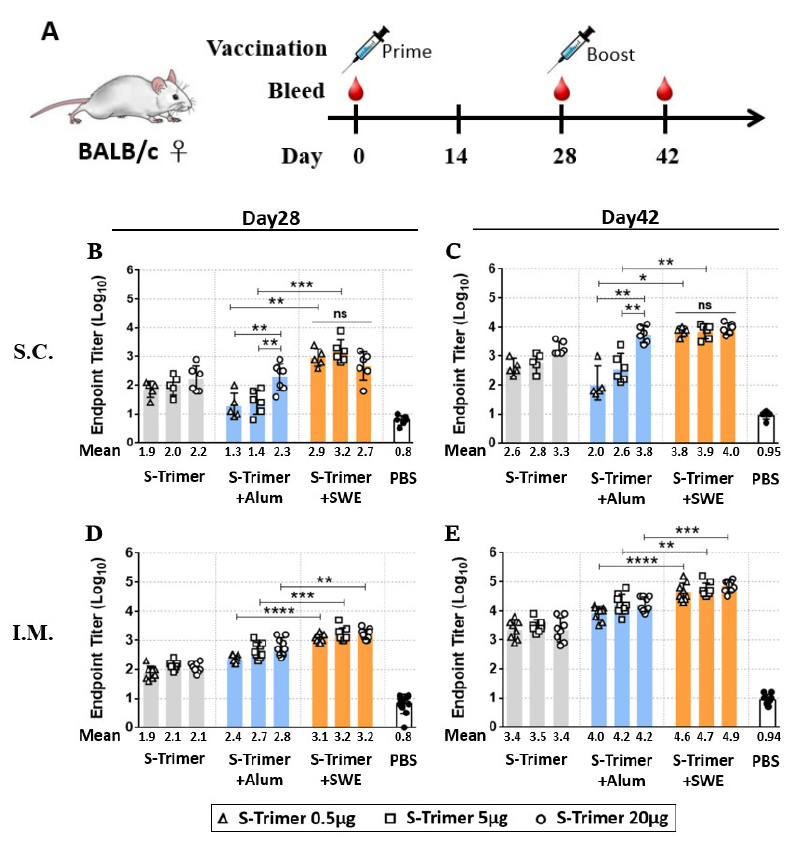
Figure 2. Detection of S-Trimer-specific antibodies in serum of vaccinated BALB/c mice. ( A ) Schematic showing the schedule for vaccination and serum collection. BALB/c mice were immunized with various doses of S-Trimer (0.5 μg, 5 μg, or 20 μg) that was nonadjuvanted (gray) or adjuvanted with 250 μg Alum (blue) or SWE (orange) twice on Day 0 and 28. The PBS-injected group was the blank control. Serum was collected on Day 0, 28, and 42. Using ELISA to access IgG titers against S- Trimer in serum, which collected after the first or second dose vaccination via ( B , C ) subcutaneous (SC) injection, n = 5–6/group, or ( D , E ) intramuscular (IM) injection, n = 8–9/group. Each symbol represents the endpoint titer from an individual mouse; each bar represents the geometric mean ± 95% confidence interval (CI) of IgG endpoint titer from the group. Statistically significant differences compared within adjuvanted vaccine groups by two-tailed Mann–Whitney test. * p < 0.05, ** p < 0.008, *** p < 0.0005, **** p < 0.0001; ns: not significant. S-Trimer (0.5 μg or 5 μg or 20 μg) either nonadjuvanted or with adjuvants, 250 μg of aluminum hydroxide (Alum), or SWE (1:1 ratio by volume). Serum from the vaccinated mice was collected on Days 28 and 42. Via SC injection, all the vaccine groups exhibited a detectable antibody response against S-Trimer after a single-dose vaccination, as revealed by ELISA (enzyme-linked immunosorbent assay). The total IgG endpoint titer (Log10) of the serum among the vaccine groups collected at Day 28 ranged from two to three and subsequently increased approximately one order for each group after boosting at Day 42. SC vaccination with the S-Trimer adjuvanted and SWE elevated the level of anti-S binding antibody (Figure 2B,C), ACE2 competitive titer (Figure 3A), and viral neutralization titer (Figure 3B) more than vaccination without the adjuvant or with the Alum. Although var- ious doses of S-Trimer antigen were included in each group, the humoral antibody re- sponse induced by the SWE-adjuvanted (S-Trimer/SWE) groups did not show significant differences among various antigen doses. Instead, a dose-dependent effect was observed